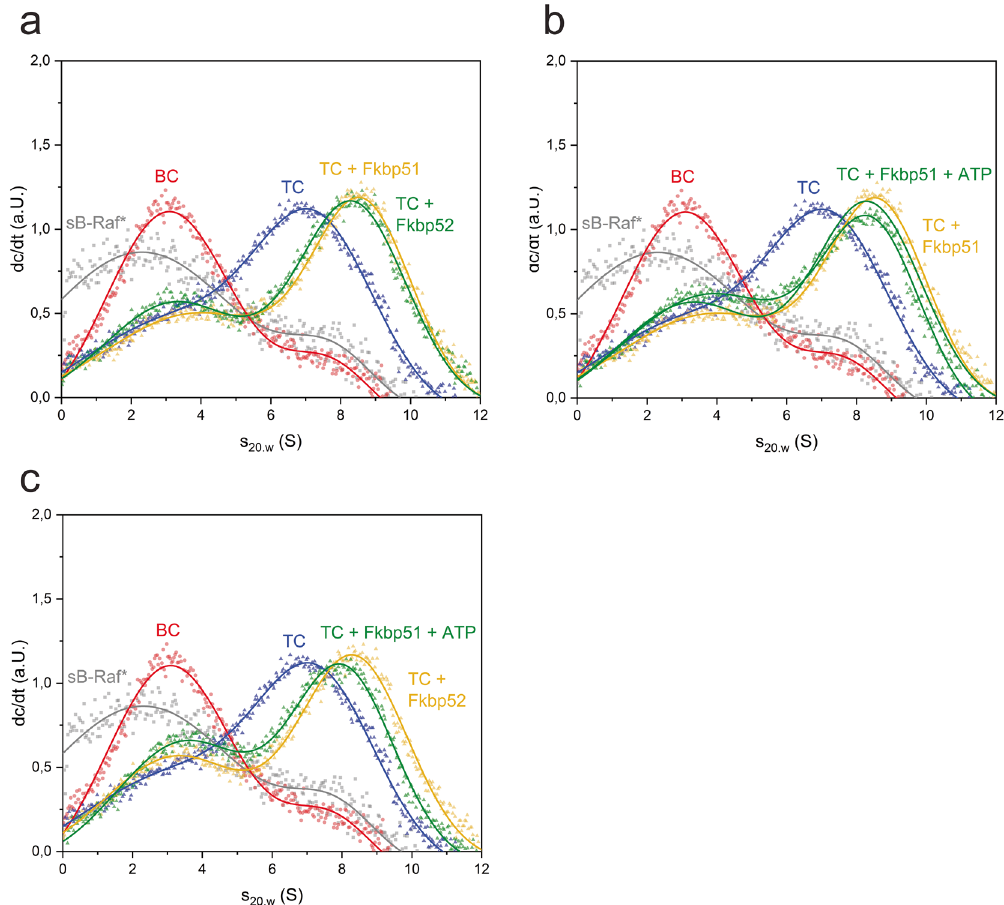
Figure 3. Formation of quaternary complex in the human system. (a) Formation of quaternary complex with human homolog chaperons Fkbp51 and Fkbp52. (b) Influence of nucleotides on the quaternary complex with Fkbp51. (c) Influence of nucleotides on the quaternary complex with Fkbp52. sB-Raf•Cdc37 binary complex is abbreviated with BC, whereas TC stands for the sB-Raf•Cdc37•Hsp90 ternary